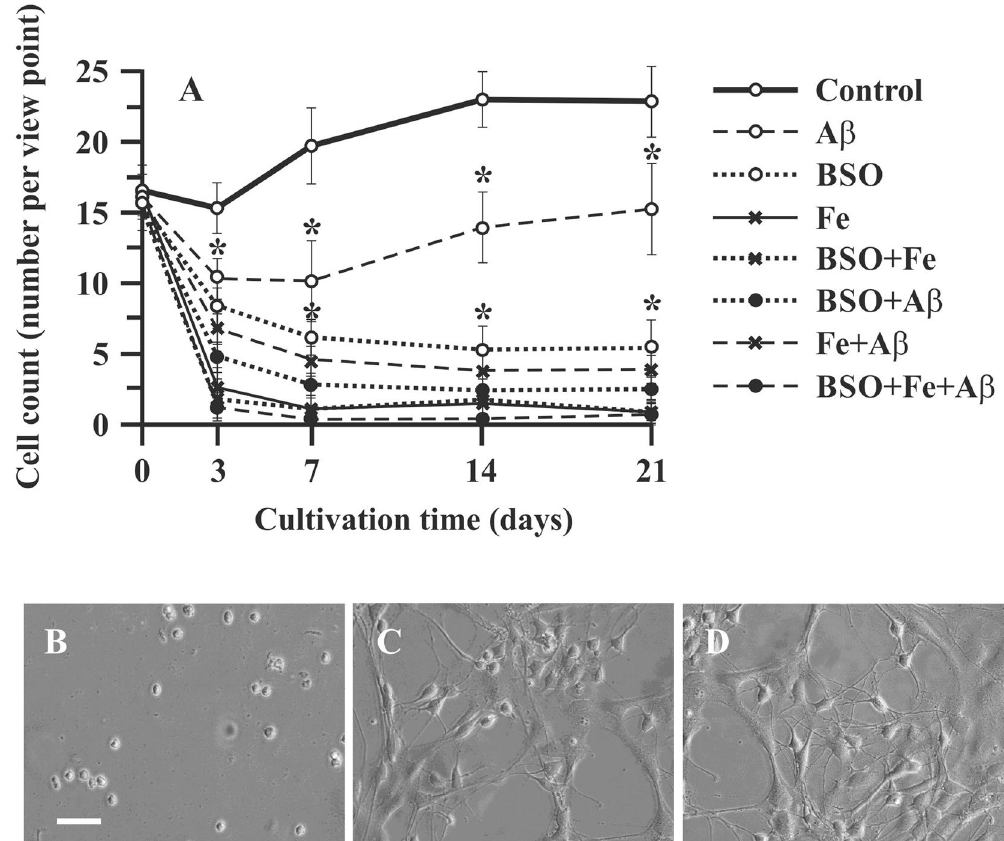
Figure 1. Effect of Aβ, BSO, and Fe2 + on neuronal cell count and morphology. ( A ) Changes in the number of primary rat hippocampal cells. ( B ) Neuronal cell morphology on the 7th day of culture. ( C ) Neuronal cell morphology on the 14th day of culture. ( D ) Neuronal cell morphology on the 21st day of culture. Scale bar, 100 μm. n = 10. * P < 0.05. The error bars indicate the mean ± SD. Hippocampal cells were isolated from